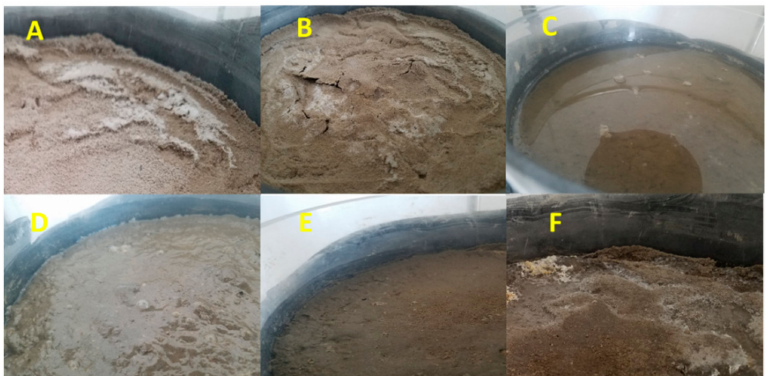
Figure 3. Pictures of salt crusts in di ff erent conditions. ( A ) salt precipitation; ( B ) salt crust elevated with some breakage; ( C ) water ponding after flooding; ( D ) water ponding in recession; ( E ) surface soil drying; ( F ) salt crust elevated again without breakage.